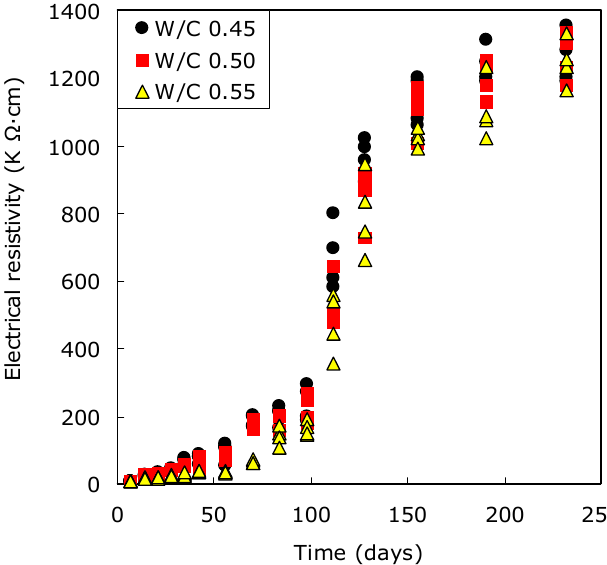
Figure 5. Electrical resistivity measurements of the air-dried concrete without chloride.